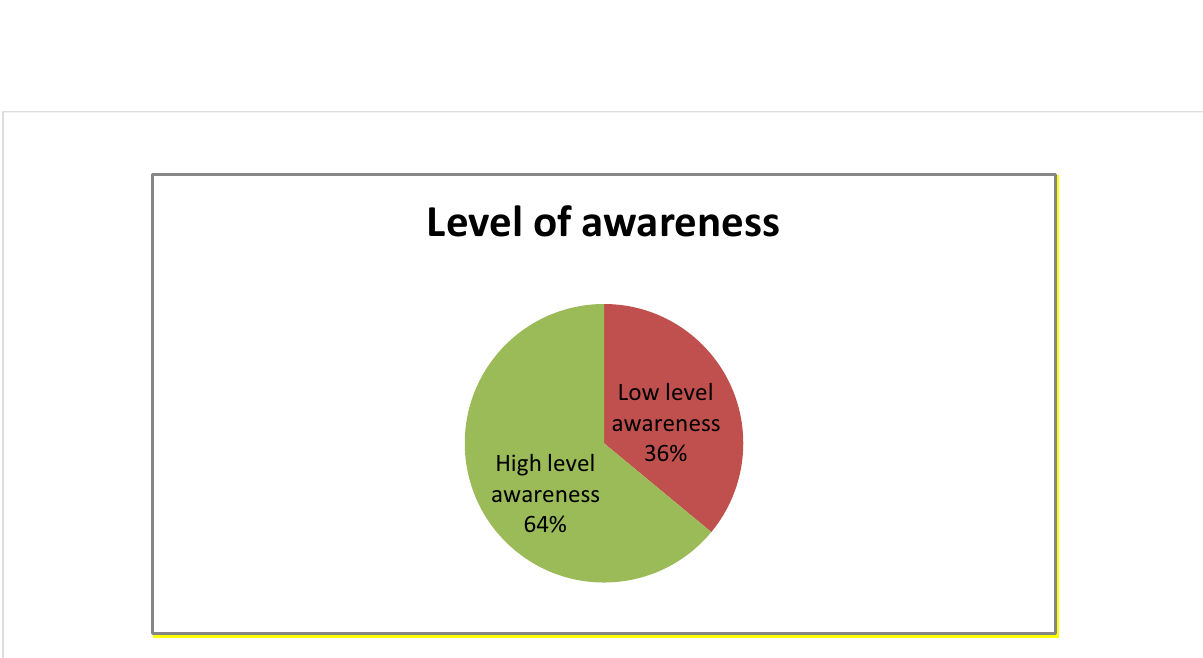
FIGURE 2 Level of awareness of prostate cancer in men 40 years of age and older in Mizan Aman town, Bench Sheko zone in SNNPR, South West Ethiopia,